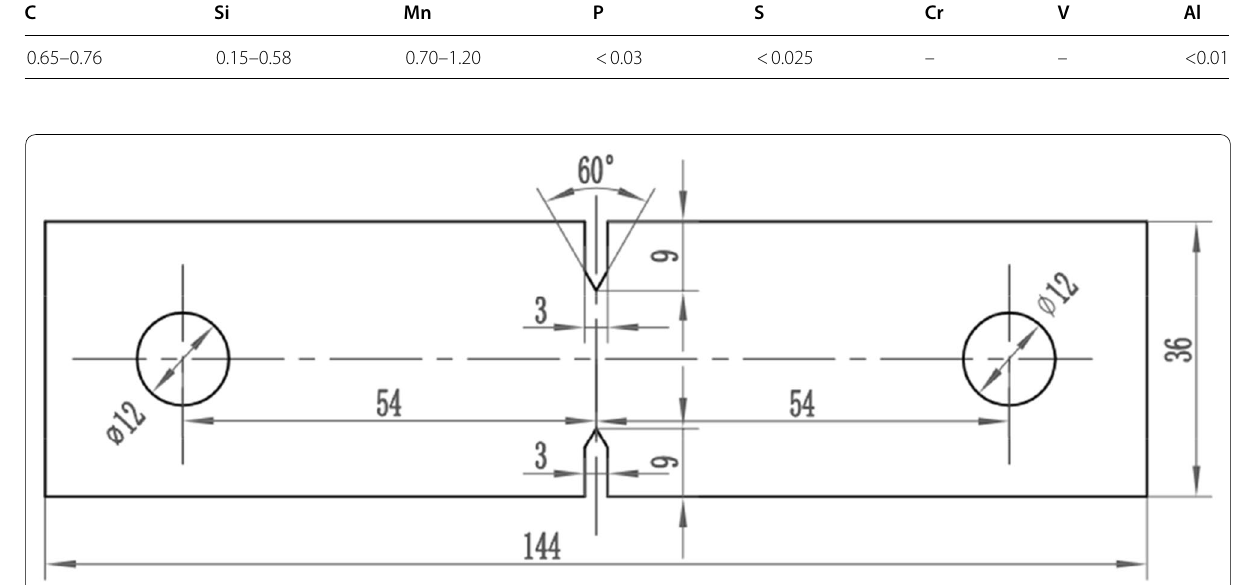
Figure 3 Sample